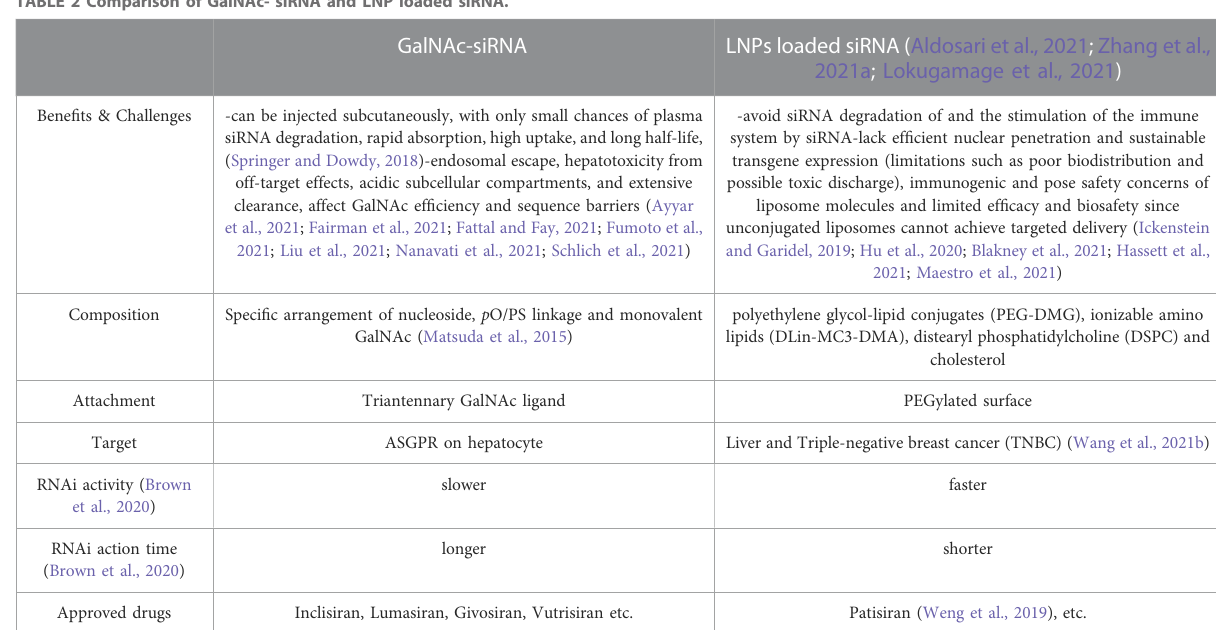
TABLE 2 Comparison of GalNAc- siRNA and LNP loaded